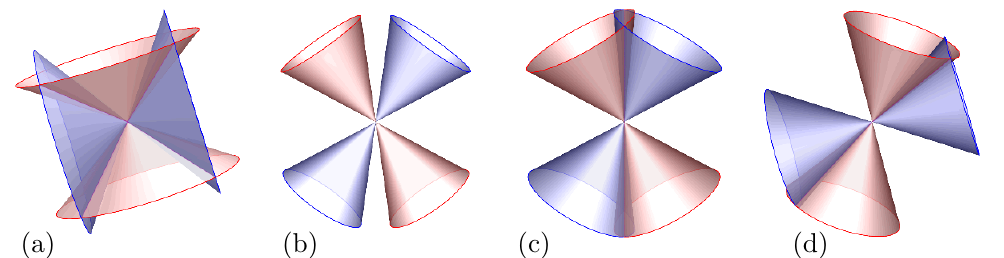
Figure 1 . Some possible intersections of two null